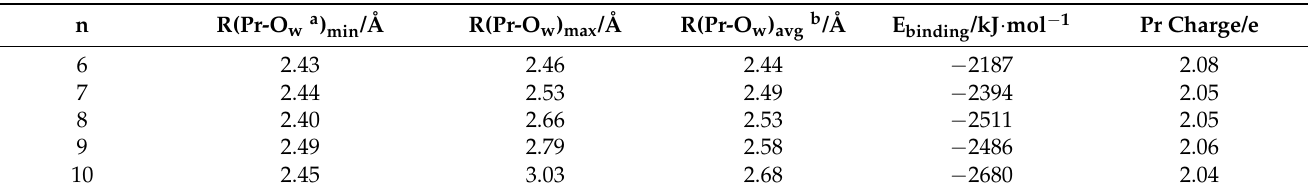
Table 1. The equilibrium geometries parameters and binding energy of [Pr(H 2 O) 6 − 10 ] 3+